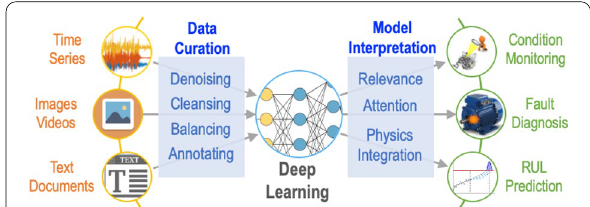
Figure 2 DL-driven pipeline for monitoring, diagnosis and